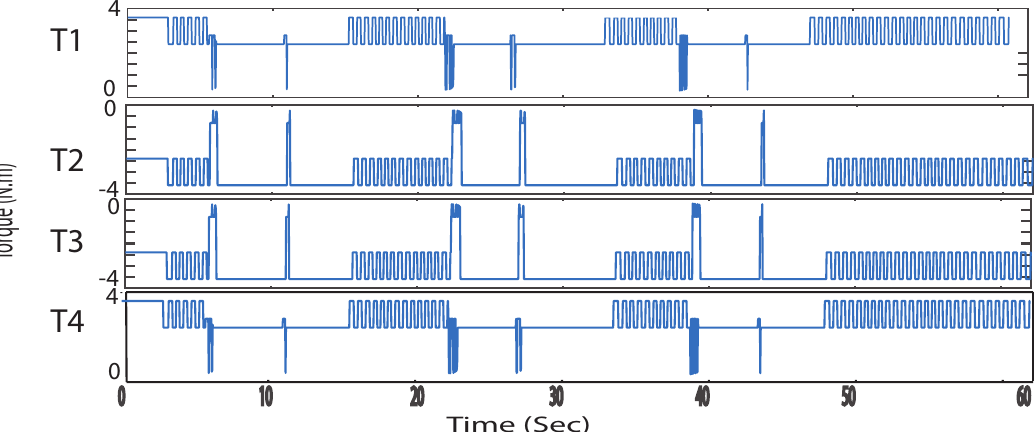
Figure 8. Path of the robot for state 1, All wheels working.